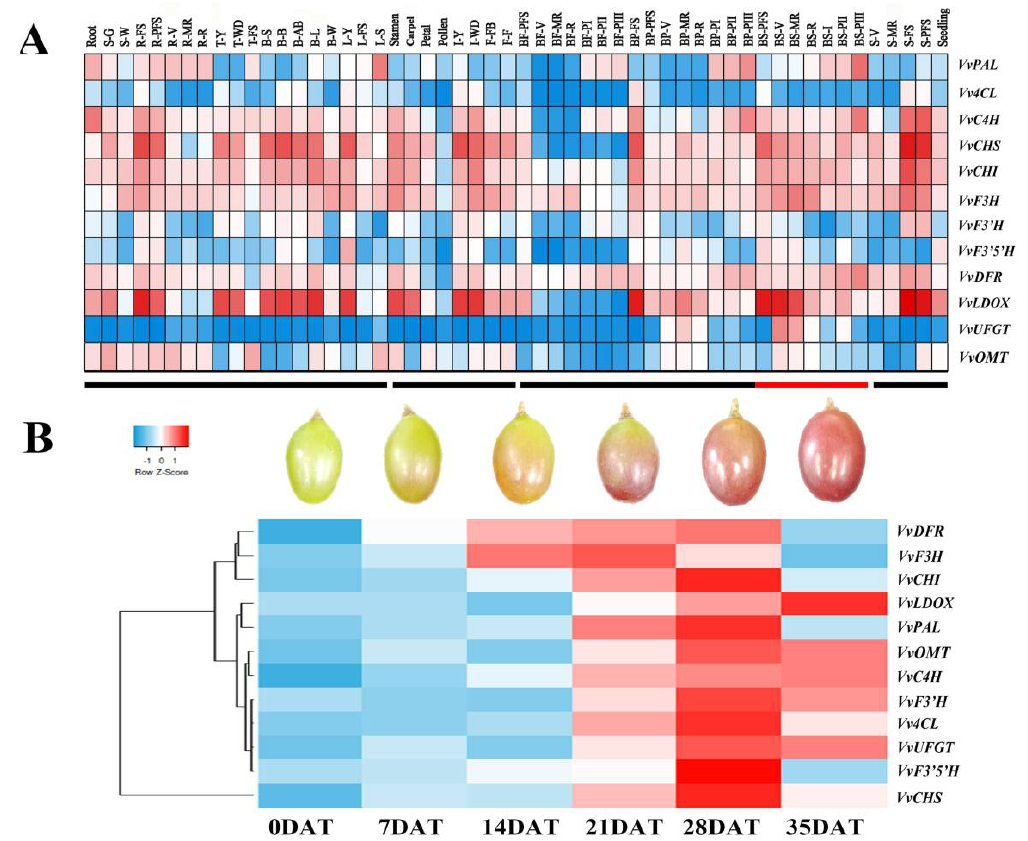
Figure 6. Expression profiles of anthocyanin-related genes. ( A ) The expression of anthocyanin-related genes in different organs and tissues. ( B ) The expression of anthocyanin-related genes of different development periods. Root: root; S-G: